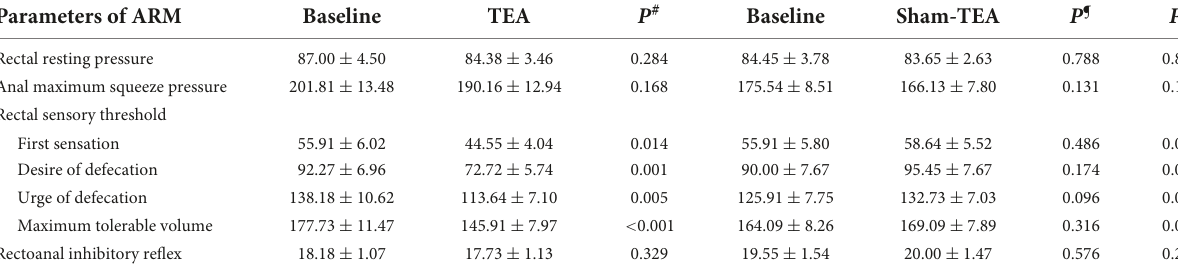
TABLE 2 Comparison of parameters of ARM before and after treatment in TEA group ( n = 22) and sham-TEA group ( n = 22). Parameters of ARM Baseline TEA P # Baseline Sham-TEA P ¶